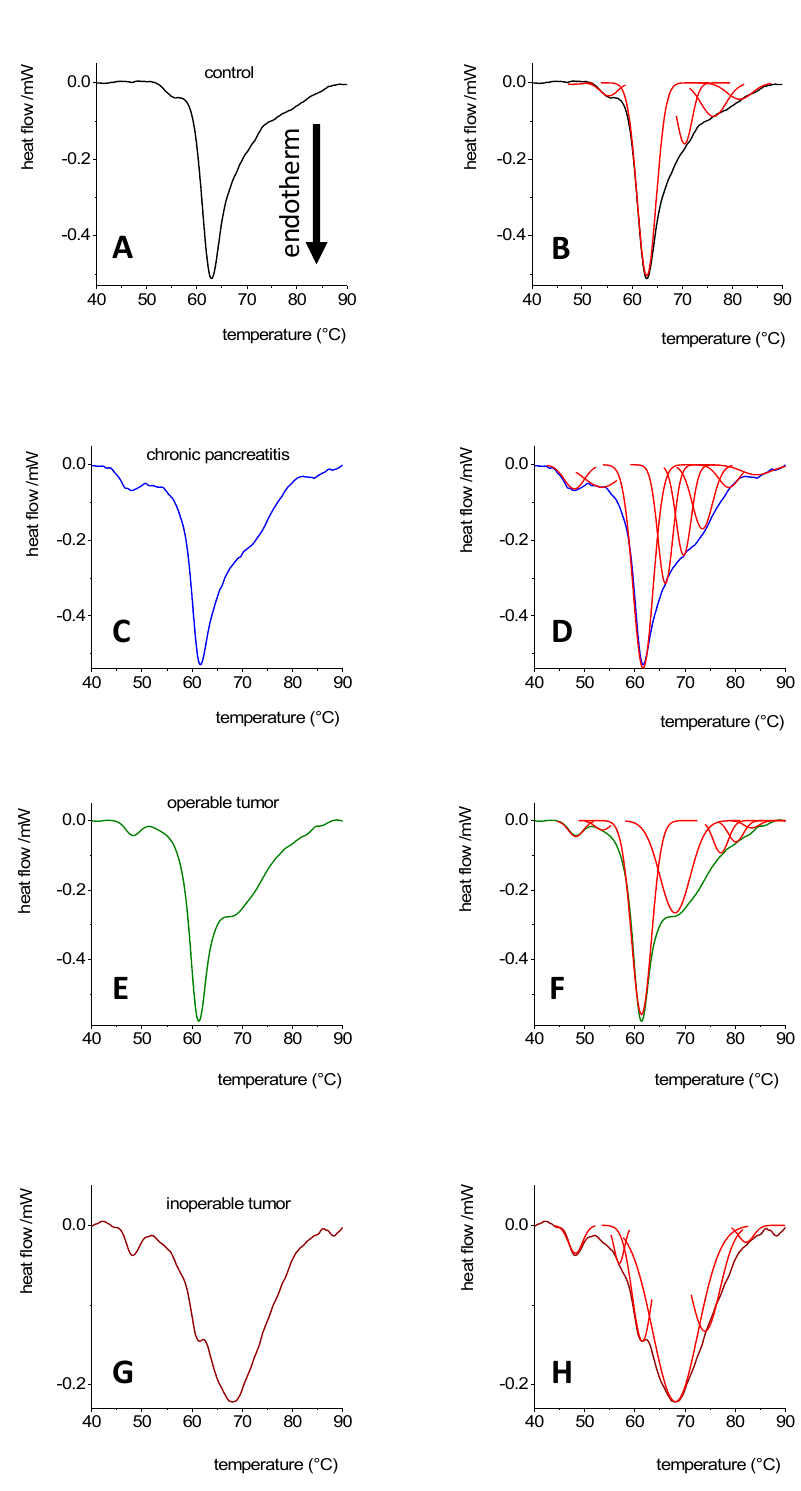
Figure 3. DSC curves [38] and their deconvolution in case of blood plasma from control ( A , B , n = 5), chronic pancreatitis ( C , D , n = 5), operable ( E , F , n = 11) and inoperable pancreatic adenocarcinoma ( G , H , n = 5).